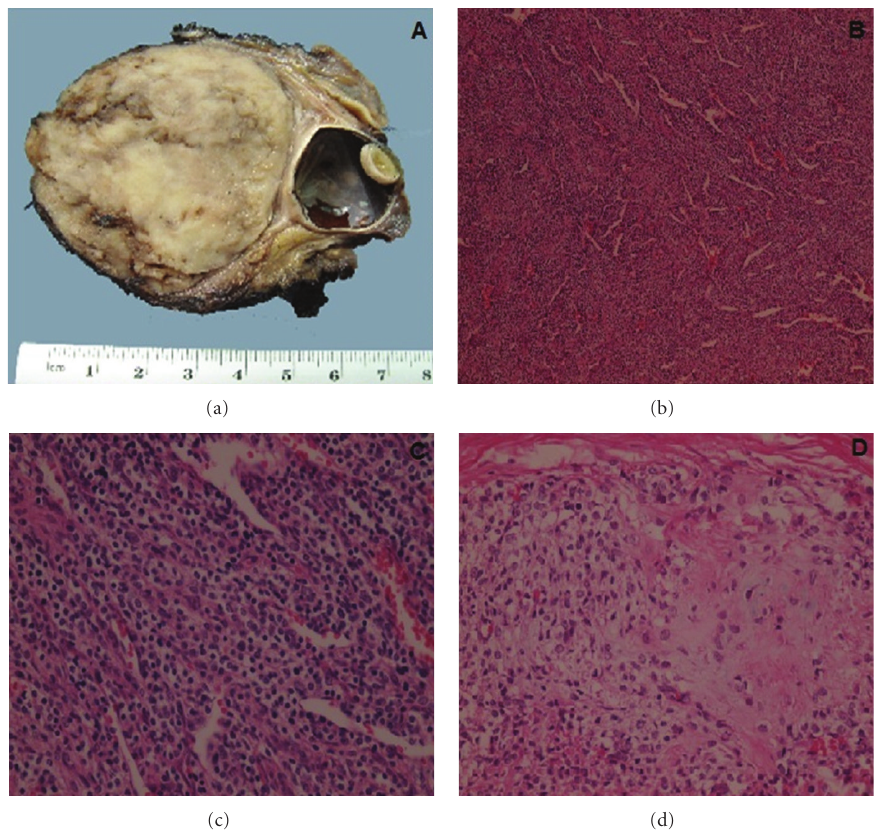
Figure 4: (a) Macroscopic view of the resected specimen. (b) Microphotography (4x) of the neoplasm showing a hemangiopericytoma-like vascular pattern, with proliferation of small, round cells with clear cytoplasm. (c) Closer view of the previous microphotography (40x), showing the small round cells surrounding the vessels. (d) Microphotography (40x) showing the transition between well di ff erentiated cartilage and small cell